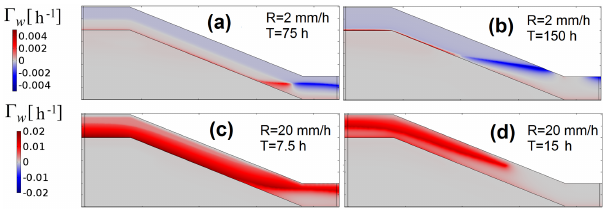
Figure 8. Water exchange rate distribution. Positive values (red): mean water exchange from preferential flow domain to matrix; neg- ative values (blue): mean water exchange from matrix to preferen- tial flow domain.